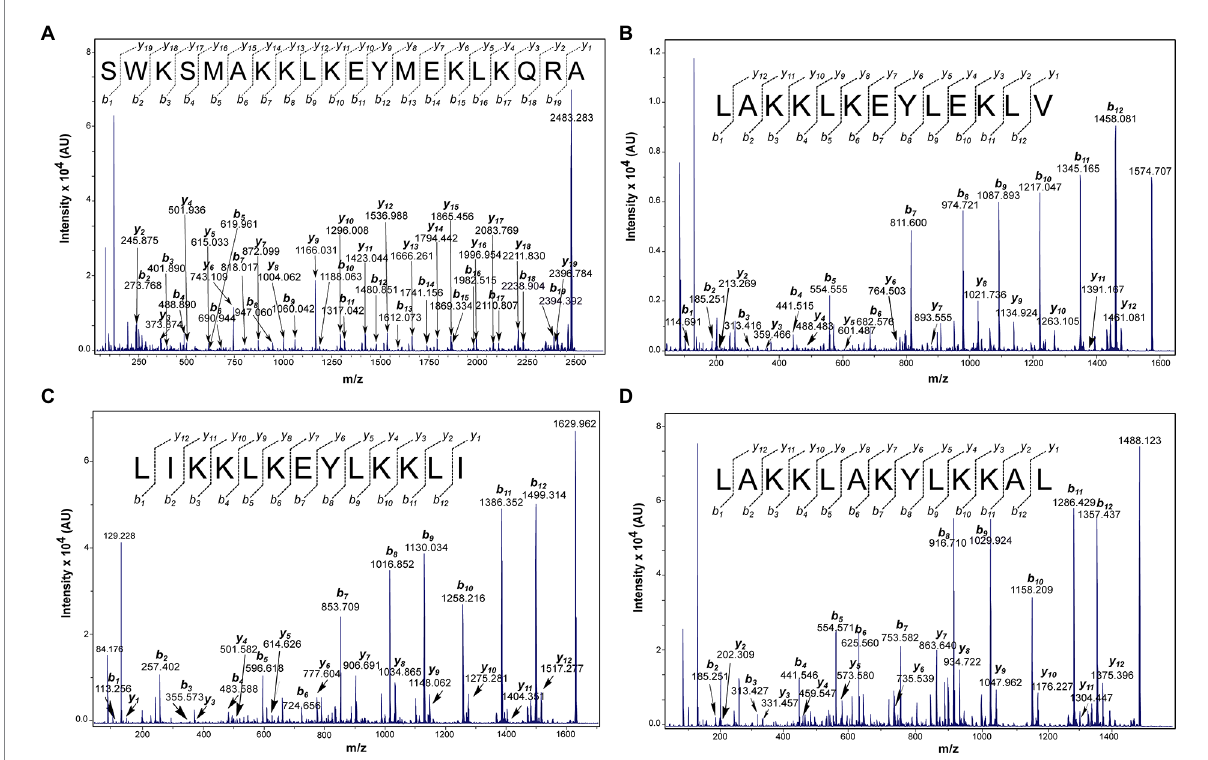
FIGURE 2 Matrix Assisted Laser Desorption Ionization Time of Flight Mass Spectrometry (MALDI-ToF MS/MS) spectra of the peptides indicating -y and -b series. (A) Ltc-3a, parental ion: 2483.283 m.z − 1 ; (B) Lt-MAP1, parental ion 1574.707 m.z − 1 ; (C) Lt-MAP2, parental ion: 1629.962 m.z − 1 ; and (D) Lt-MAP3, parental ion: 1488.123 m.z − 1 . The data were acquired in LIFT mode and the sequences were determined